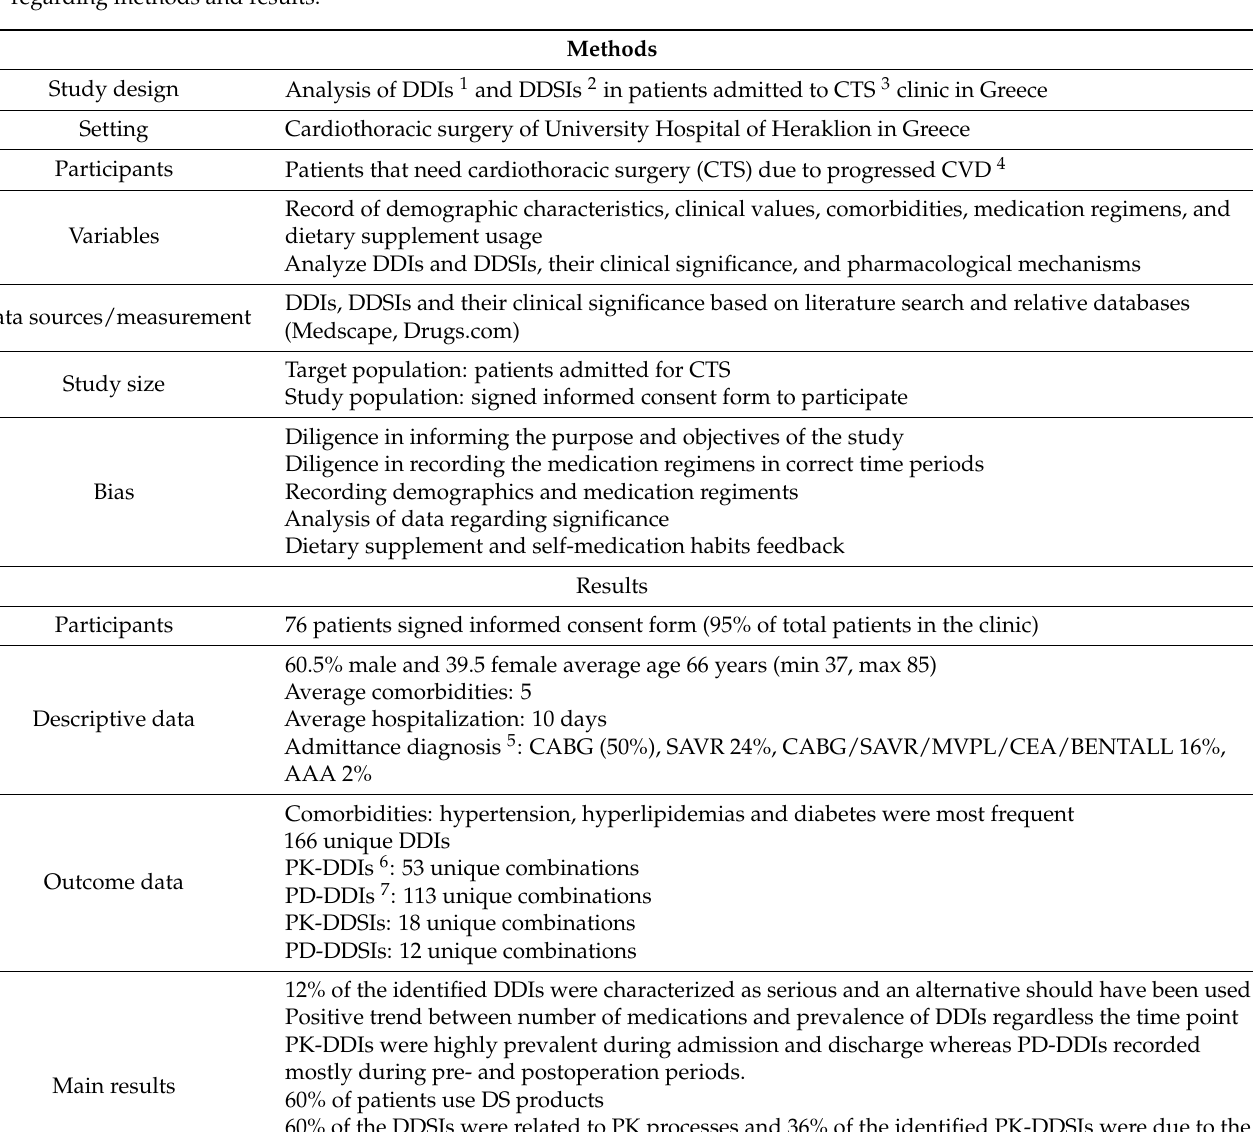
Table 1. Strengthening the Reporting of Observational Studies in Epidemiology (STROBE) information for the study regarding methods and